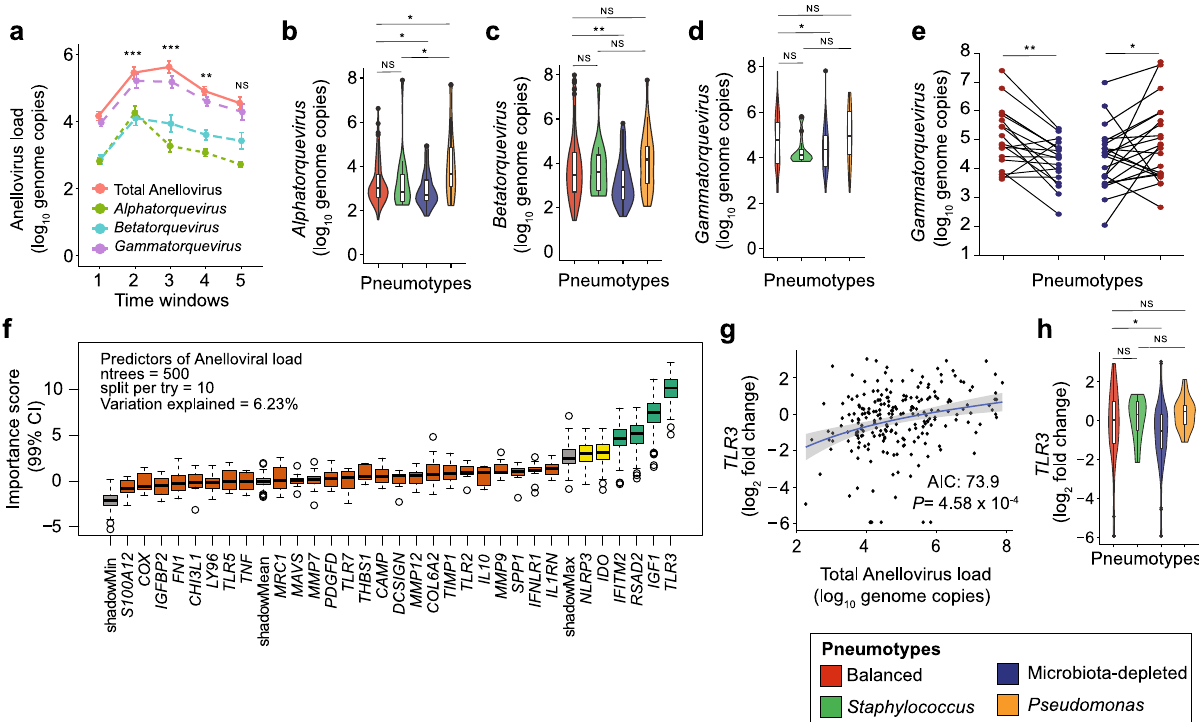
Fig. 5 Anellovirus loads differ according to pneumotype and correlate with host physiology in the transplanted lung. a Longitudinal progression of Anellovirus load (log 10 pan-Anelloviridae genome copies, pink) and its three major genera: Alphatorquevirus (green), Betatorquevirus (turquoise) and Gammatorquevirus (violet) over fi ve time windows after transplantation. Data presented here as mean viral load (points) with error bars showing ±SD. Statistical signi fi cance is shown for total Anellovirus loads against time windows ( n = 225, ANOVA, F (5, 219) = 13.57, two-sided, P = 6.7 × 10 − 10 ). b – d Violin plots show distribution of Alphatorquevirus ( n = 217, Kruskal test, χ 2 = 17.04, df = 3, two-sided, P = 6.9 × 10 − 4 ), Betatorquevirus ( n = 215, ANOVA, F (3, 211) = 4.57, two-sided, P = 3.97 × 10 − 3 ) and Gammatorquevirus ( n = 216, Kruskal test, χ 2 = 8.94, df = 3, two-sided, P = 3.0 × 10 − 2 ) load across pneumotypes (plot colors). e Intra-individual analysis of Gammatorquevirus loads upon transition from Pneumotype Balanced (Red) to Pneumotype MD (Blue) (Wilcoxon test, two-sided, paired, P = 1.7 × 10 − 3 ) and vice-versa (Wilcoxon test, two-sided, paired, P = 1.72 × 10 − 2 ). Paired data (joined by black lines) presented here are viral genome copies (log 10 , points). f Importance scores (99% Con fi dence Interval) of host genes in predicting anellovirus load analyzed by Random Forest regression model and Boruta feature selection. Predictor genes are categorized into Con fi rmed (Green), Tentative (Yellow) and Rejected (Orange), ntrees = number of decision trees, splits per try = number of random predictors sub-sampled and percent variance explained. g Scatter plots show correlation between expression (log 2 fold) of TLR3 (stepwise regression AIC:73.9, ANOVA, t = 3.56, P = 4.58 × 10 − 4 ) with total anellovirus load (log 10 genome copies) across samples ( n = 231). Linear regression is shown by the blue line with gray shaded area showing 95% con fi dence interval. h Violin plots show distribution of TLR3 expression (log 2 fold) across the four pneumotypes ( n = 231, Kruskal test, χ 2 = 10.66, df = 3, two-sided, P = 1.3 × 10 − 2 ),. All box plots including insets show median (middle line), 25th, 75th percentile (box) and 5th and 95th percentile (whiskers) as well as outliers (single points). Post hoc analyses (95% Con fi dence Interval) were done by using Tukey ’ s test (ANOVA) or Dunn ’ s test (Kruskal test) with False Discovery Rate (FDR). * P < 0.05, ** P < 0.01, *** P < 0.001, NS = not signi fi irreversible drop in FEV1 below 80% of the baseline value, with prior exclusion of alternative confounding diagnosis (See “ Methods ” ). Pneumotype Staphylococcus and Pneumotype Pseudomonas were associated with lower FEV1 values overall, with a frequent substantial decline below 80% predicted (Dunn ’ s test, P = 3.0 × 10 − 2 , Fig. 6h), while Pneumotype Balanced , along with Pneumoty- pe MD , was linked to preserved lung function.